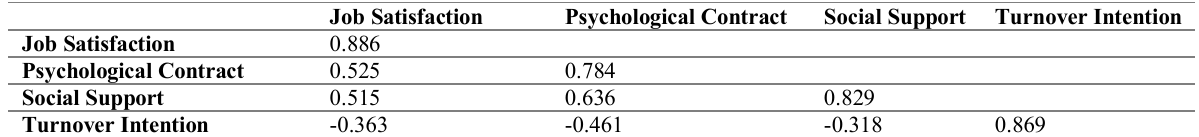
Table 4: Discriminant validity assessment